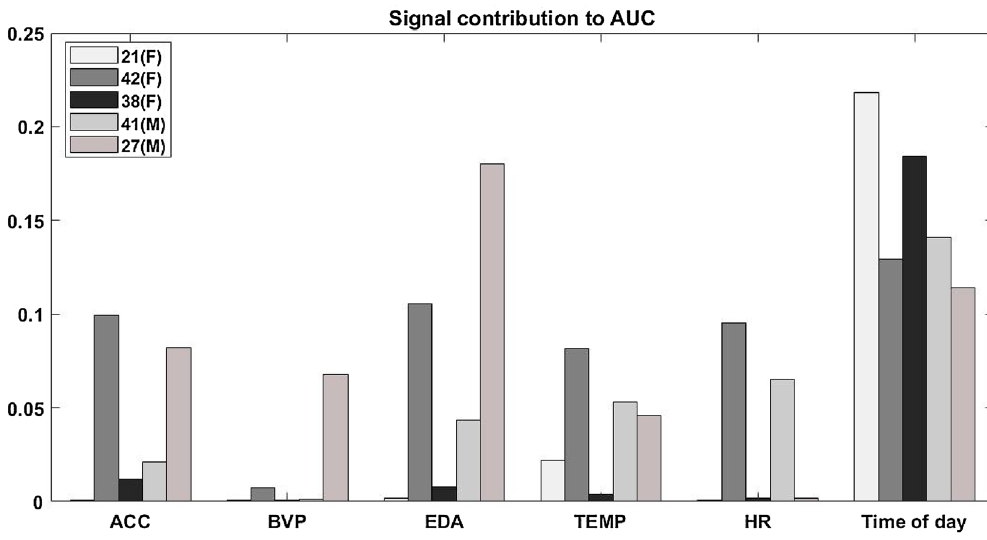
Figure 3. Influence of each signal and its related features on classifier performance. The algorithm was trained and tested five times with each signal removed, and the average AUC difference from the full result was